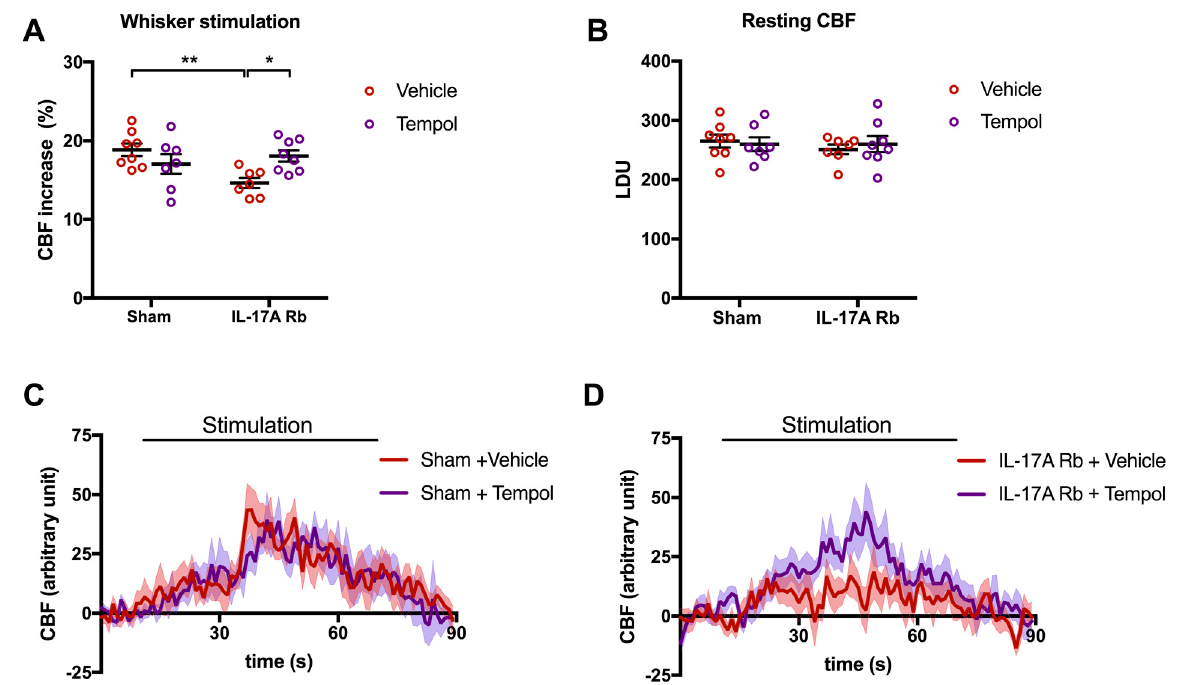
Figure 7. Tempol treatment prevents the neurovascular coupling alteration induced by IL-17A . CBF in response to whiskers stimulations measured in vivo by laser Doppler flowmetry in C57BL/6 male mice receiving IL-17A Rb through an osmotic minipump (50 pg/kg/h, 7 days) and treated with or without Tempol (1 mM changed every 2 days) administered in the drinking water. The graphs depict ( A ) CBF as percentage changes with respect to the initial CBF value, ( B ) resting CBF value as LDU, and ( C , D ) 1 second average curves of the evoked CBF, expressed in arbitrary unit. SEM is represented by the lighter tone shade surrounding each curve. Data were analyzed using an ANOVA for factorial design with repeated measures followed by a Bonferroni post-test. * p < 0.05 and ** p < 0.01; n = 7–8 per group.